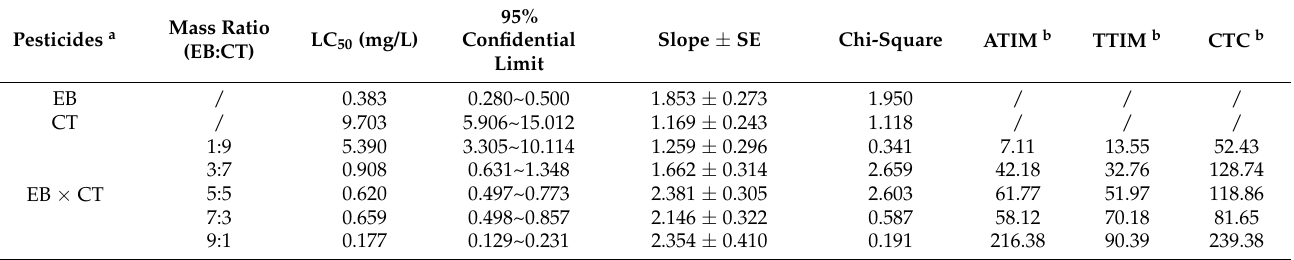
Table 1. Synergistic effect of emamectin benzoate and chlorantraniliprole in diet-incorporated bioassays.